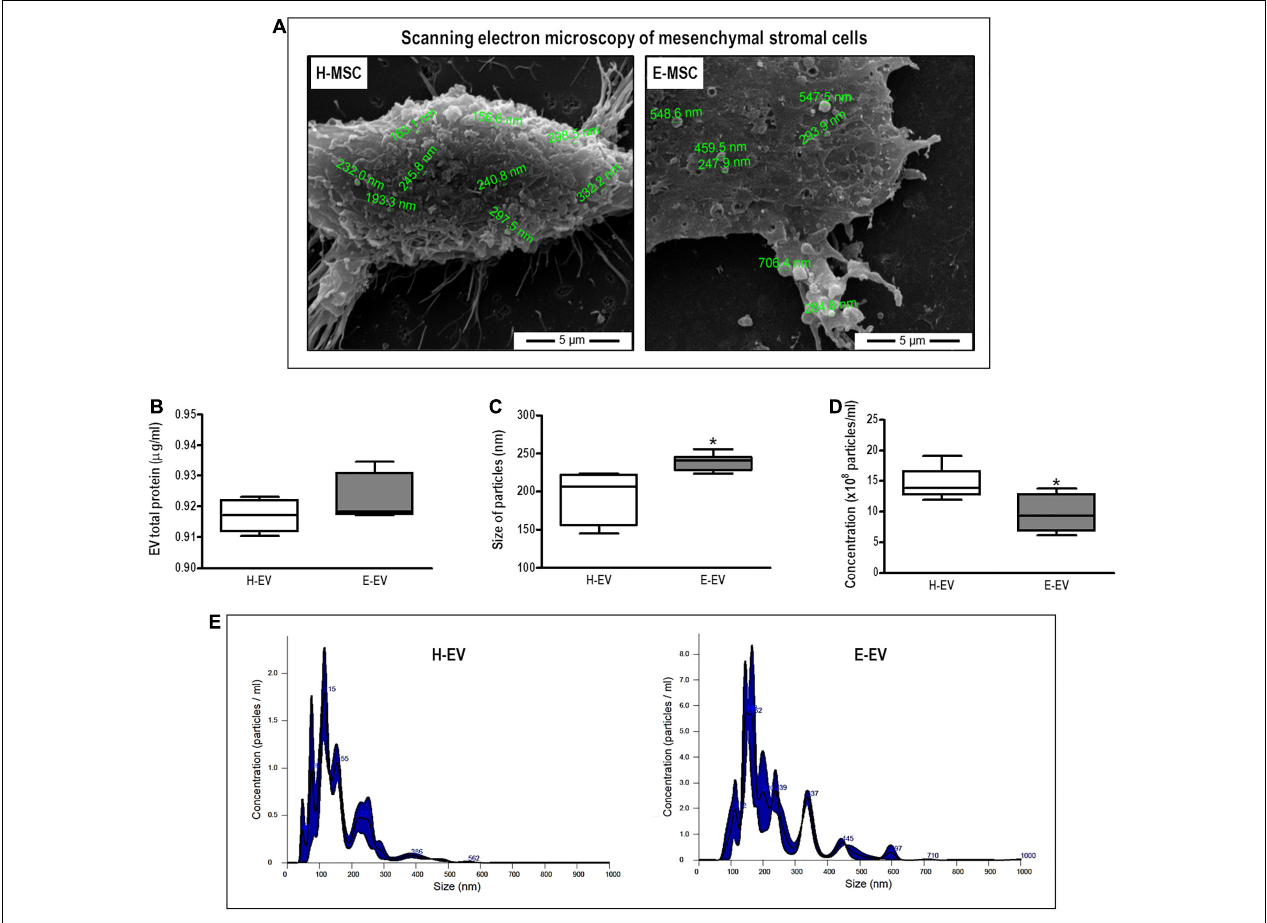
FIGURE 2 | Characterization of EVs secreted by MSCs from healthy and emphysematous donors. H-MSCs, bone marrow-derived mesenchymal stromal cells (BM-MSCs) obtained from healthy donor; E-MSCs, BM-MSCs obtained from emphysematous donors; H-EVs, extracellular vesicles derived from BM-MSCs obtained from healthy donors; E-EVs, extracellular vesicles derived from BM-MSCs obtained from emphysematous donors. (A) Representative scanning electron microscopy of H-MSCs and E-MSCs, illustrating EV release from the surface of both types of MSCs. (B–D) Characterization of H-EVs and E-EVs, as determined by total protein content (B) and the size (C) , concentration (D) , and distribution (E) of secreted particles, measured by the Bradford assay and nanoparticle tracking analysis, respectively. Data are expressed as medians (interquartile range) of 5–6 samples in each group. * P < 0.05 vs. the H-EV